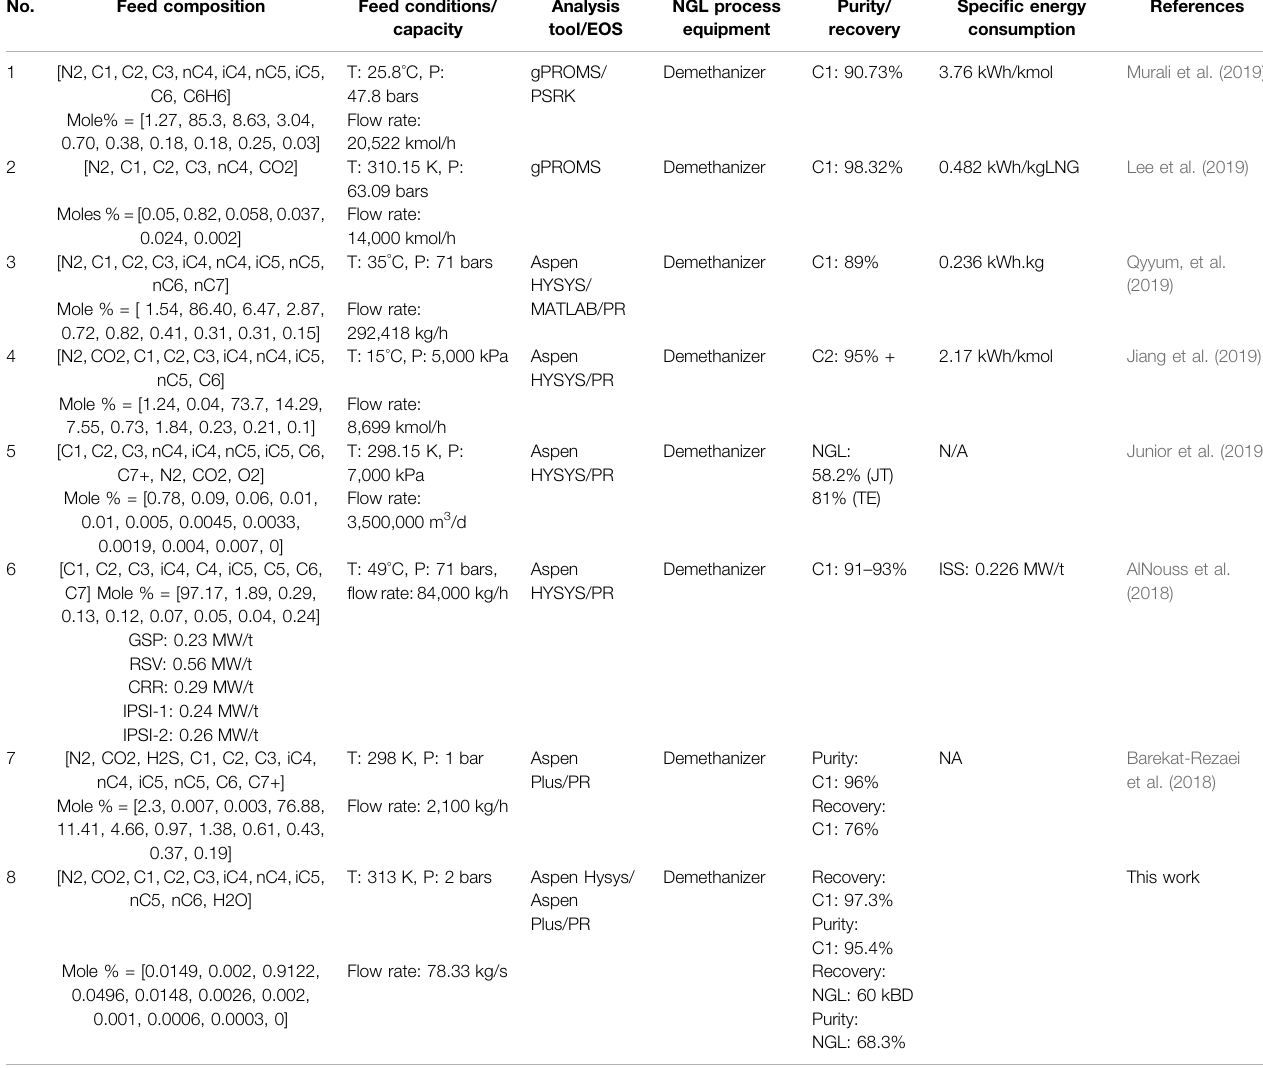
TABLE 3 | Model validation summary on NGL recovery